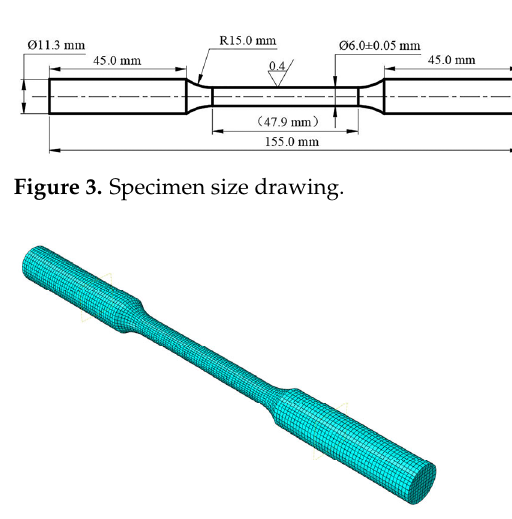
Figure 2. Tensile specimen.